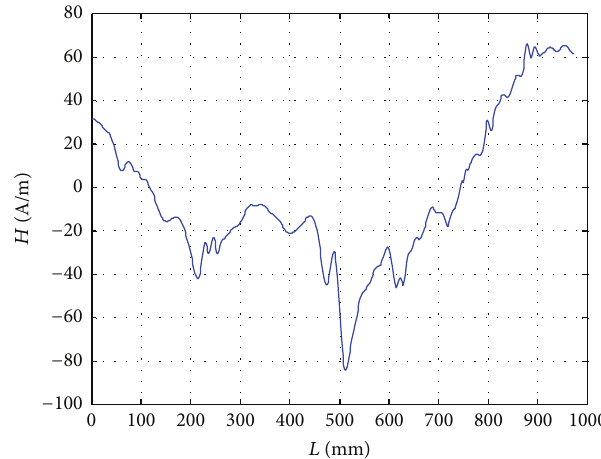
Figure 7: MMM signal after adaptive denoising.